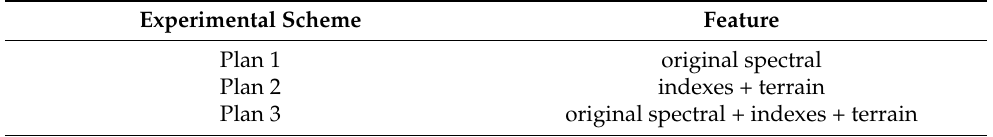
Table 3. Categories involved in the experimental